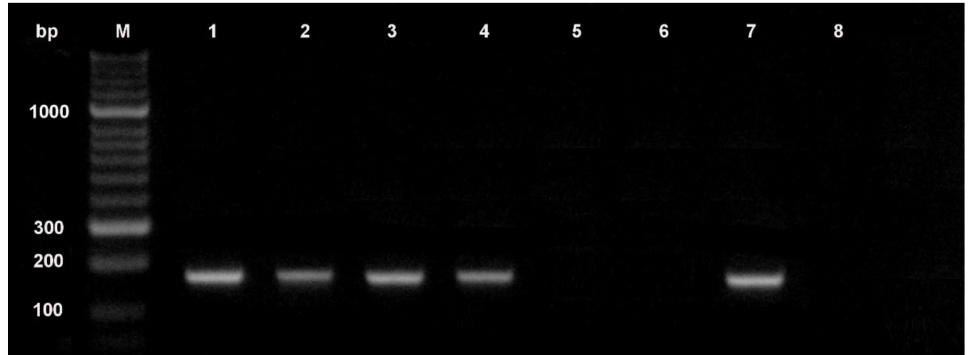
Figure 2. Detection of Fusarium oxysporum forma specialis lactucae race 1-specific DNA fragment in lettuce seeds using PCR assay. Lanes: M, HyperLadder 50 bp DNA ladder (Bioline), 1–4 F. oxysporum f. sp. lactucae race 1 isolates; 5–6 non-pathogenic F. oxysporum ; 7 positive control ( F. oxysporum f. sp. lactucae race 1 DNA); 8 negative control (water replaced genomic DNA as the